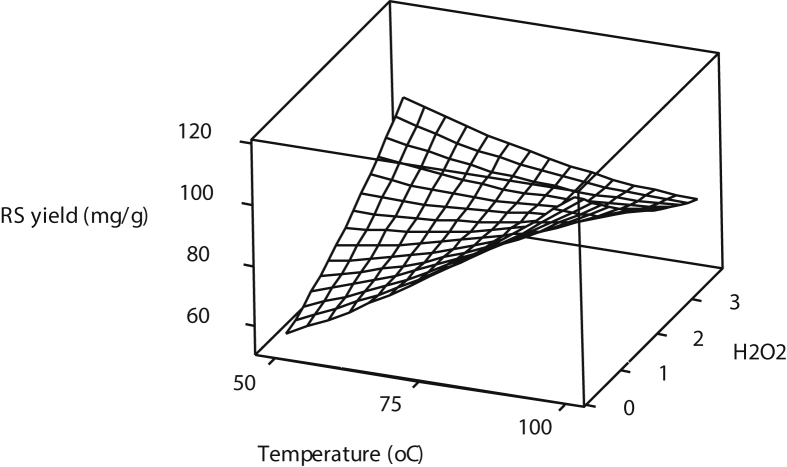
Surface plot for reducing sugar yield against %H2O2 and Temperature.